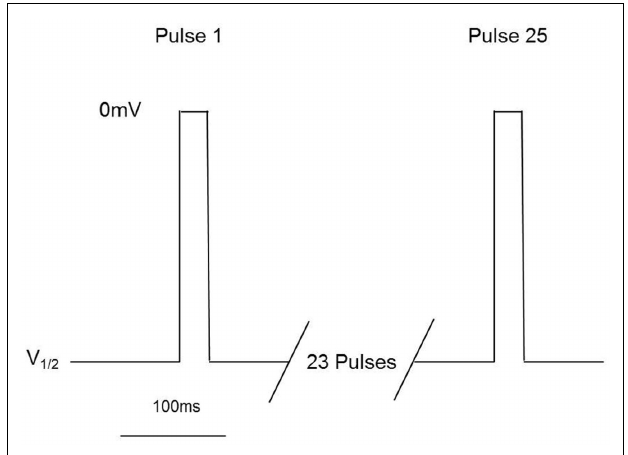
FIGURE 2 | Millipore’s voltage-gated sodium channel IonWorks Quattro™protocol. Cells are held at a voltage corresponding to ∼ V 1/2 inactivation, and subjected to 25 depolarization pulses to 0mV for 20ms. Pulses are applied every 100ms. Data from Pulse 1 and Pulse 25 are reported to assess both tonic and use-dependent inhibition.